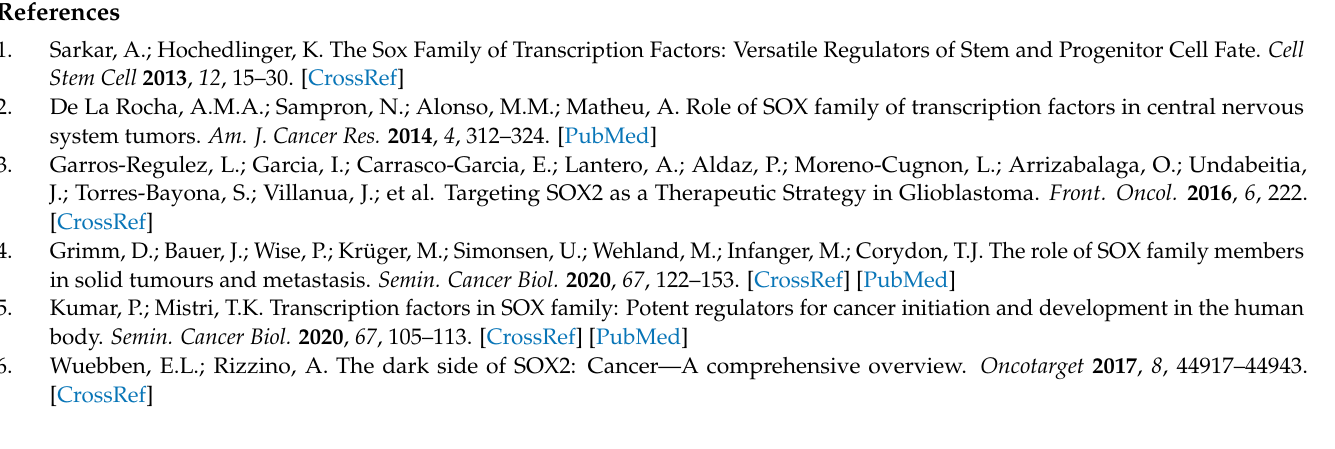
human sequence of SRR2 . Figure S2. Ectopic expression of SOX2 rescues stem cell activity in SRR2 deleted cells. Figure S3. A) Expression of p53 in SRR2 deleted GBM cells. Figure S4. Uncropped Western Blots. Table S1. Primers for CRISPR genome editing. Table S2. Primers used for Genotyping and ChIP